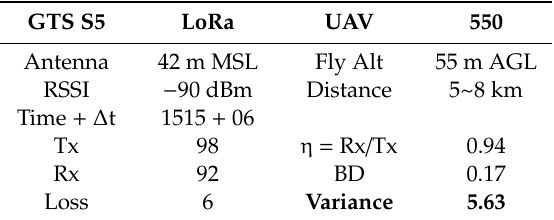
Table 5. Test data at Xi-Gan (S5).